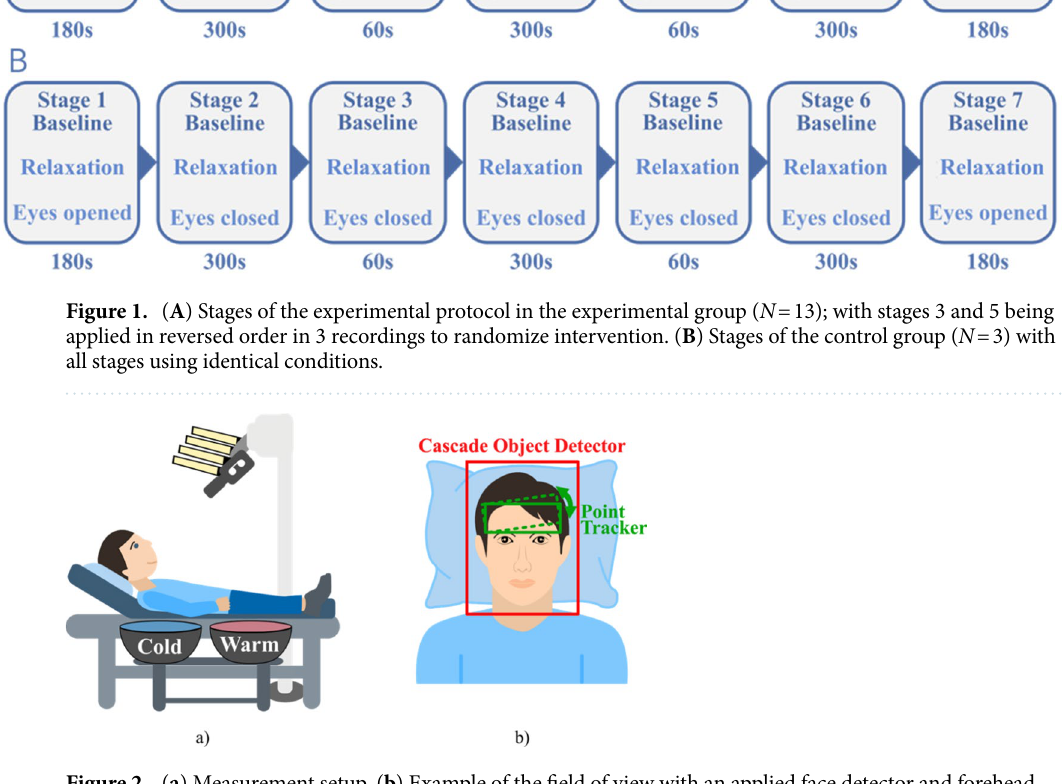
Figure 2. ( a ) Measurement setup. ( b ) Example of the field of view with an applied face detector and forehead